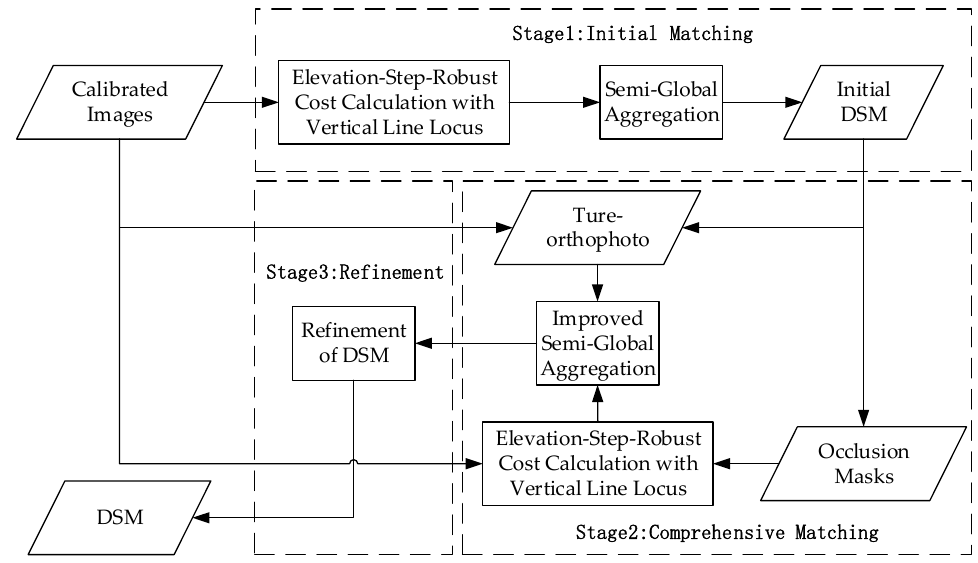
Figure 2. Flowchart of the proposed semi-global vertical line locus matching (SGVLL).